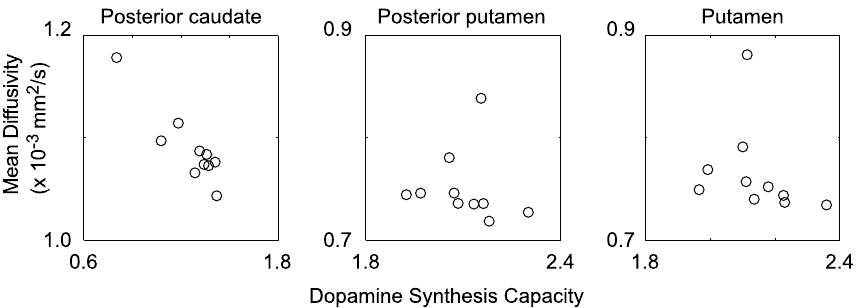
Figure 3. Scatter plots of dopamine synthesis capacity versus mean diffusivity in posterior caudate and posterior and whole putamen.